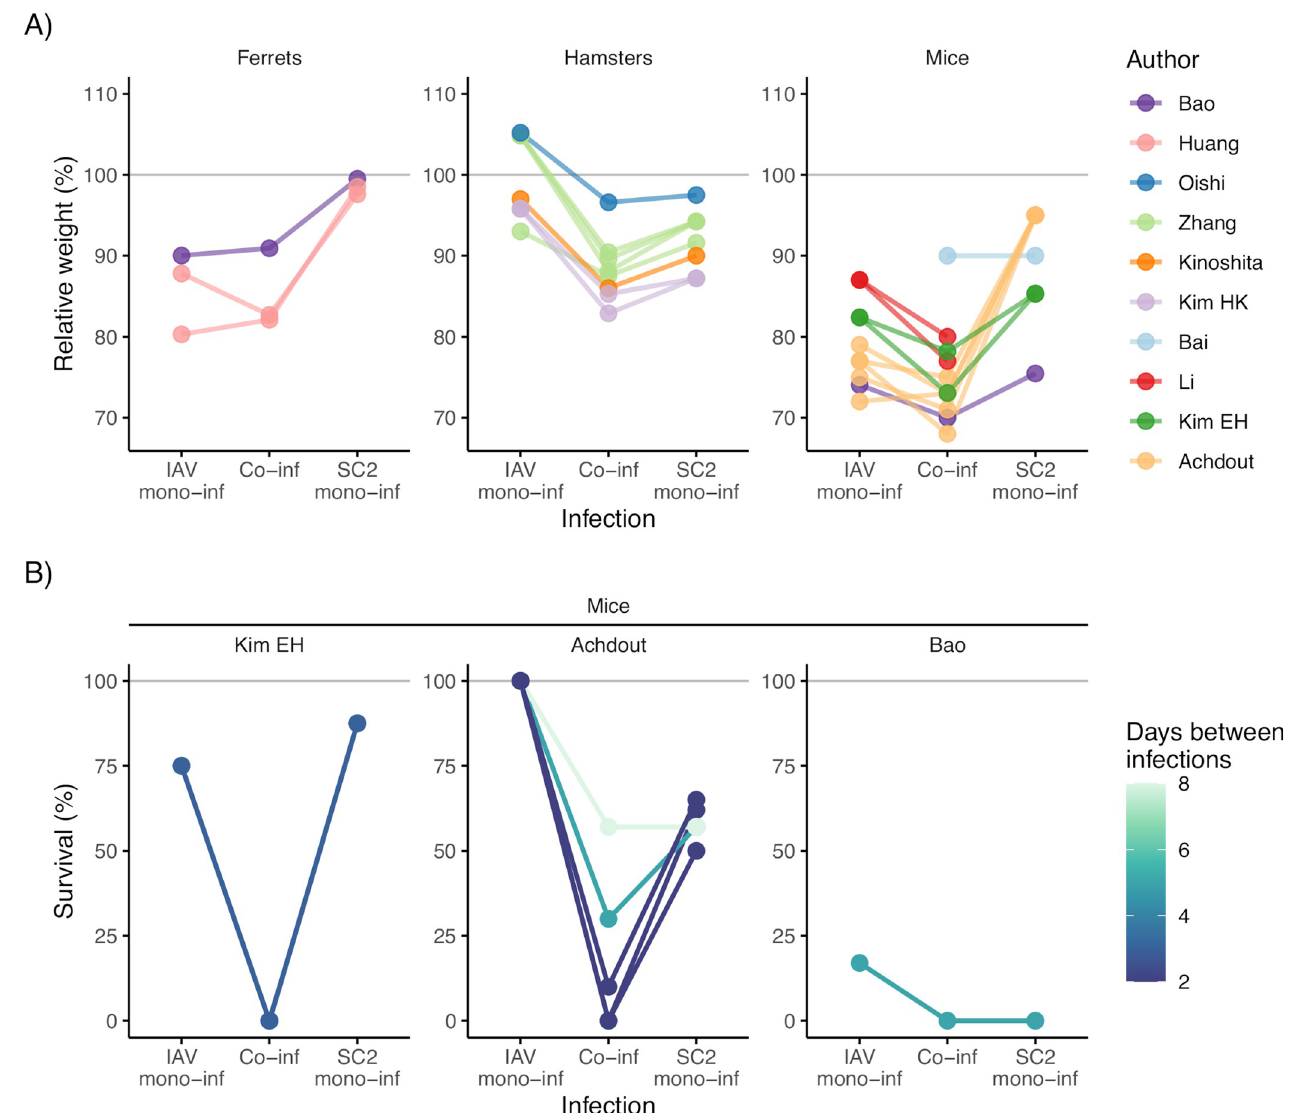
Fig 3. Summary results from animal studies assessing the effect of coinfection with SARS-CoV-2 and influenza A virus (IAV) on disease severity. [44– 49,51–54].In panel A, the y -axis values represent the weight relative to baseline, calculated when the maximal weight loss was observed (or, if the animals did not lose weight, when the maximum weight gain was observed), and colors represent different studies. In panel B, the y -axis values represent the fraction of animals alive at the end of the experiment, and colors represent the times between infections. The data from every study were extracted from the text, the tables, or the figures; all the corresponding values were checked and are available in S1 and S2